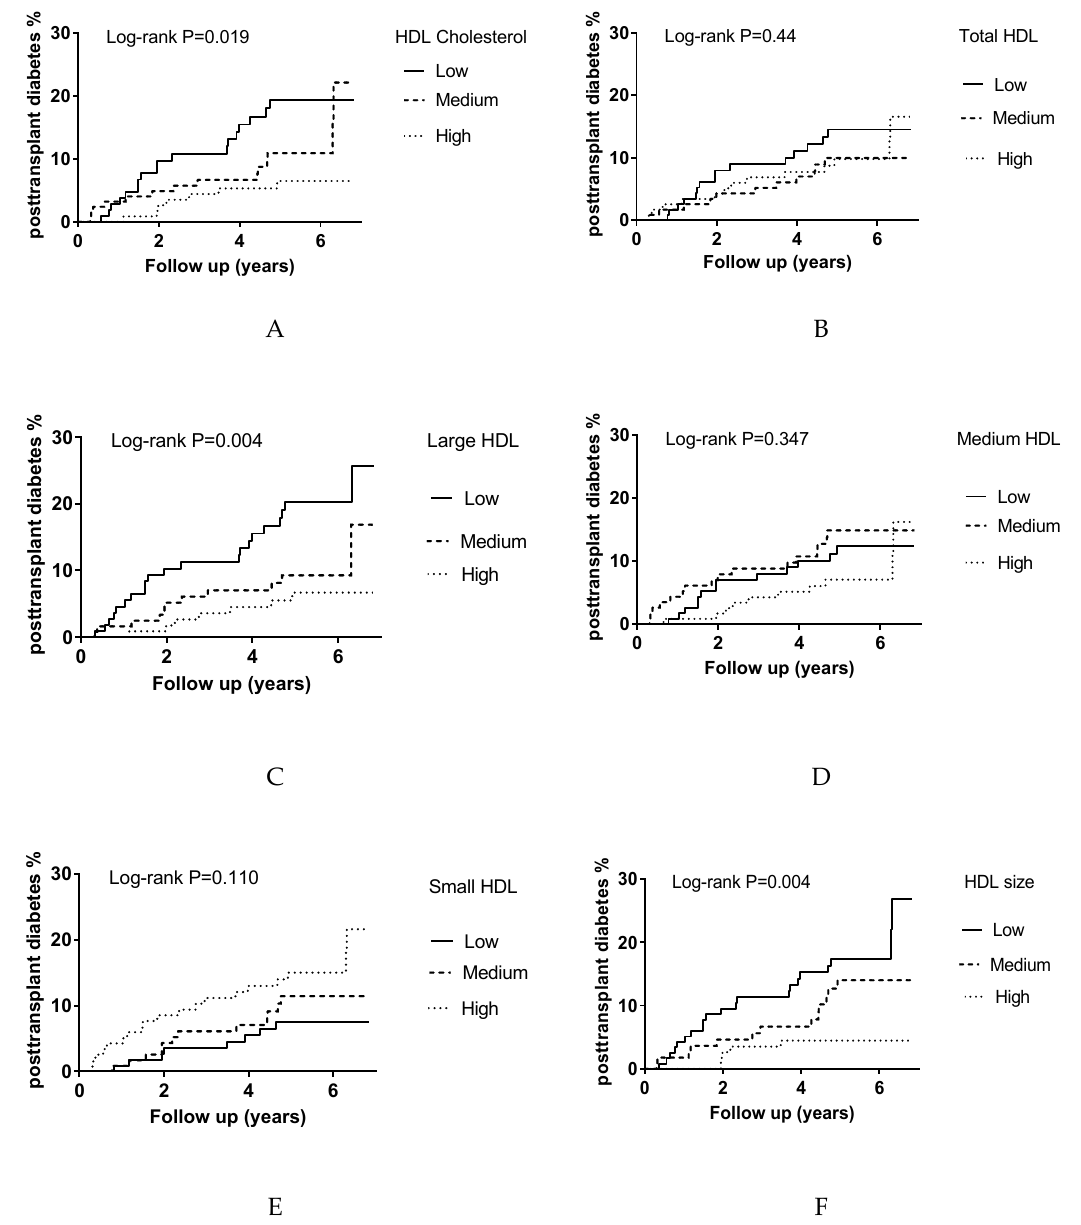
Figure 1. Kaplan–Meier curves for PTDM development according to the tertiles of HDL indices in 351 RTRs. Panel ( A ) for HDL cholesterol, panel ( B ) total HDL particles, Panel ( C ) for large HDL particles, Panel ( D ) for for medium HDL particles, Panel ( E ) for small HDL particles, and panel ( F ) for HDL size. Subsequently, we performed Cox proportional hazard regression analyses for HDL cholesterol, large HDL particles, HDL size, with incident PTDM (Table 3). Higher HDL cholesterol was associated with lower risk of PTDM in crude analyses (HR, 0.53; 95% confidence interval [CI], 0.36–0.80 per 1SD mg / dL; p = 0.002). After adjustment for age, sex, and BMI (model 1) the association remained statistically significant (HR, 0.55; 95% CI, 0.36–0.83 per 1SD mg / dL; p = 0.005). Adjustment for additional variables including alcohol consumption, smoking status, and physical activity (model 2), use of lipid-lowering medication, anti-hypertensive medication, prednisolone dose, calcineurin inhibitors, and proliferation inhibitors (model 3), eGFR, albuminuria, CMV infection, and time after transplantation (model 4), and HbA1c (model 5) did not attenuate the association between HDL cholesterol and PTDM. After full adjustment for age, sex, BMI, SBP, FPG, and TG (model 6), the negative association remained statistically significant (HR, 0.61; 95% CI, 0.40–0.94 per 1SD mg/dL; p